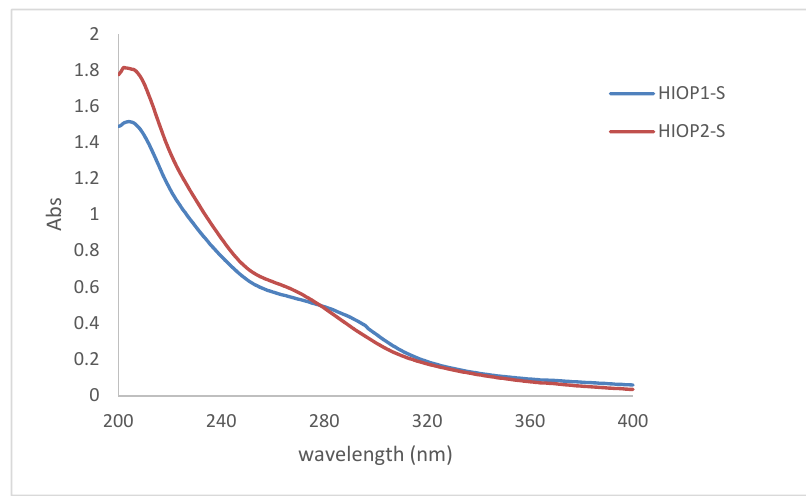
Figure 5. UV absorption spectra of HIOP1 ‐ S and HIOP2 ‐ S.